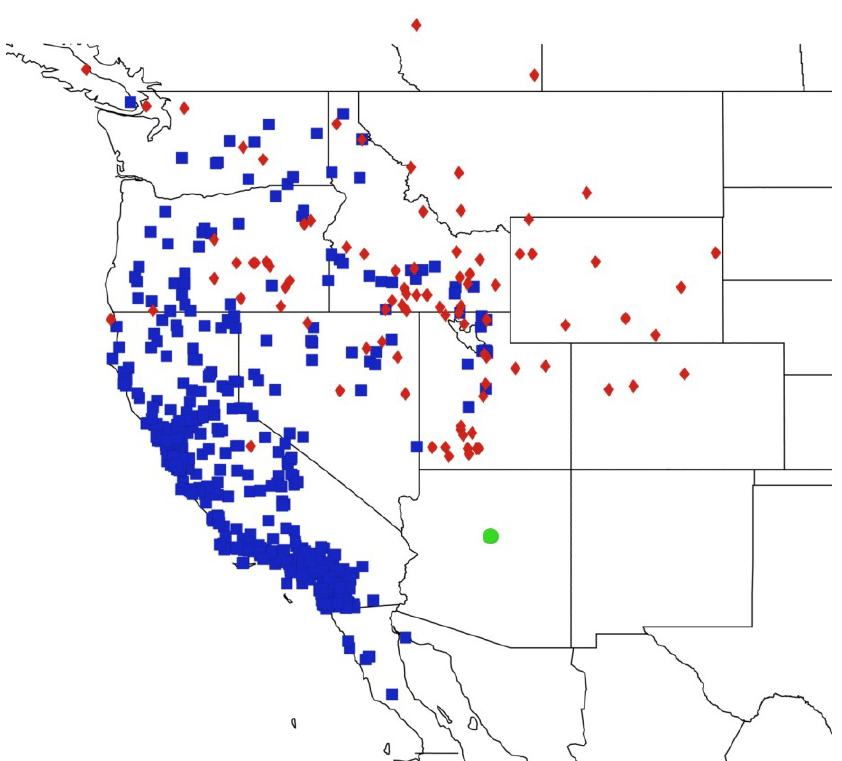
Figure 55. Distribution of Okanagana vanduzeei (blue squares), O. fratercula (red diamonds) and O. georgi (green